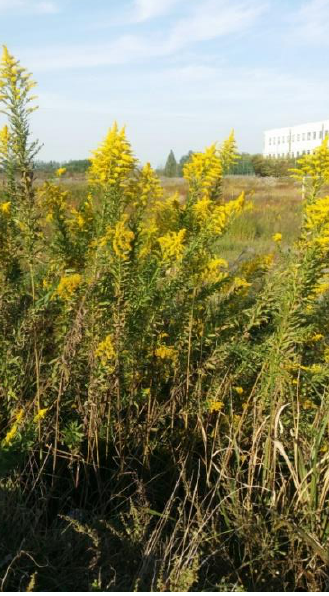
Figure 1. Photographs of invasive alien plant “tall goldenrod” ( Solidago altissima L.) in Korea.